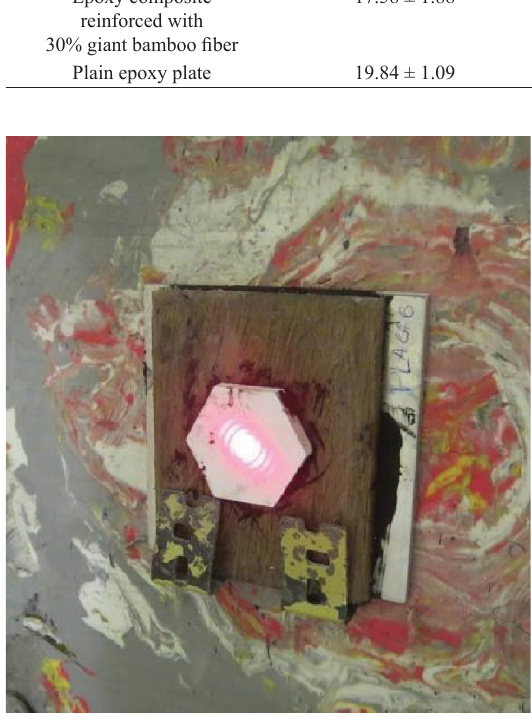
Figure 4. Actual view of a clamped MAS with giant bamboo composite plate ready to be ballistic tested. Laser beam focusing in the center of the ceramic plate as sight. Source: authors.